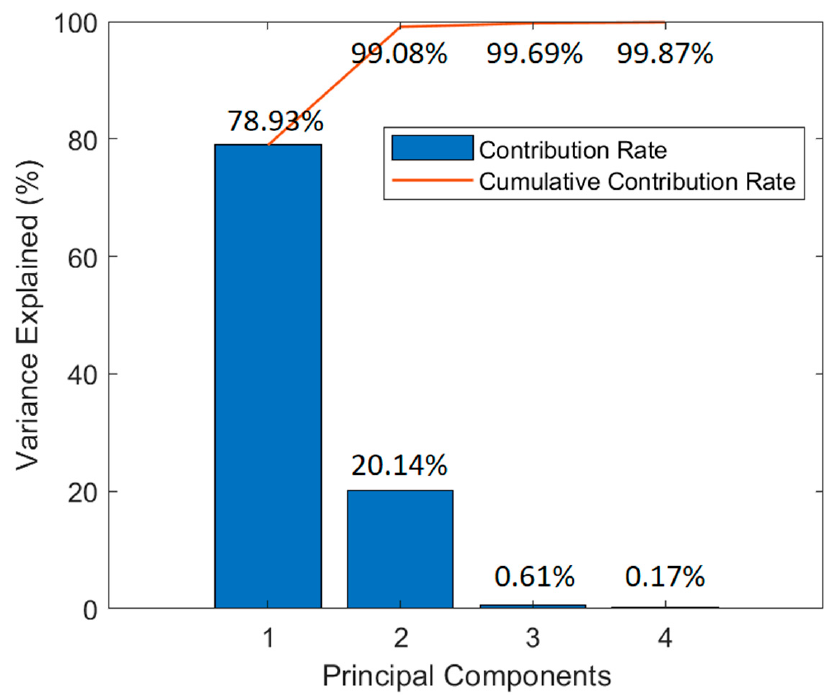
Figure 13. Contribution rate of each PC.